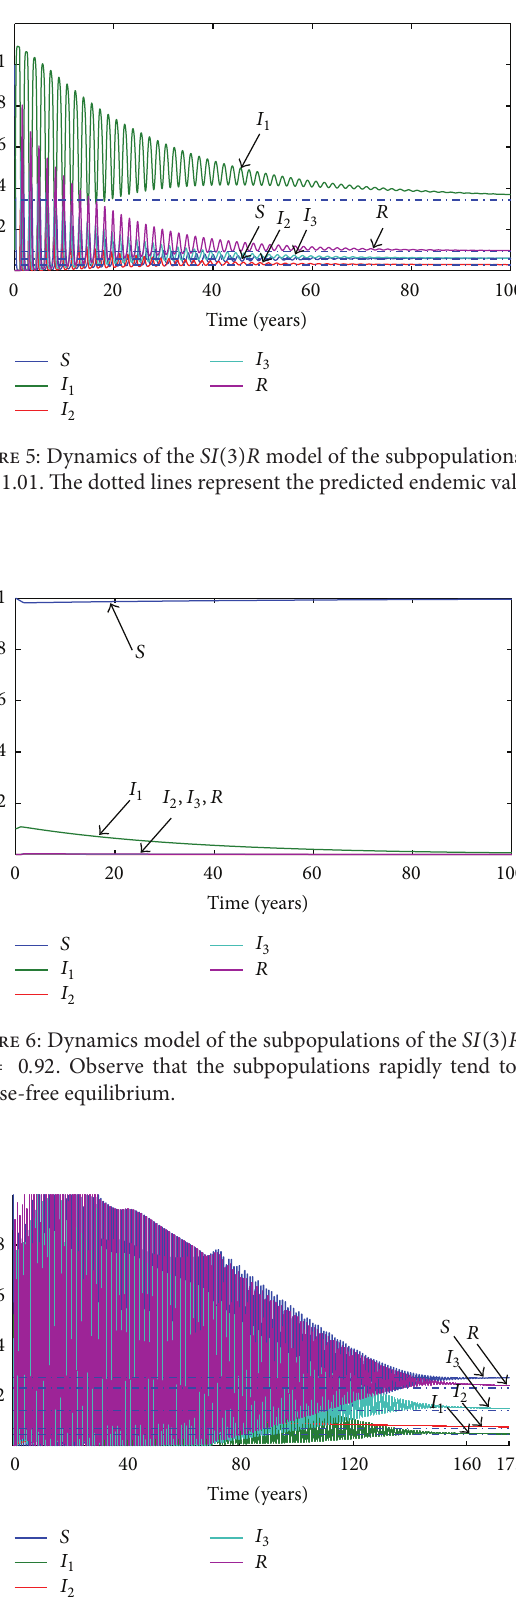
Figure 7: Dynamics of the different subpopulations of the discrete delayed 𝑆𝐼(3)𝑅 model for 𝑅 0 = 1.01 . The dotted lines represent the predicted endemic